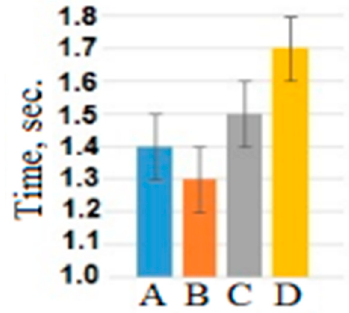
Figure 2. The reaction time averaged across all participants and assessments for different attribution objects: A—self-assessment, B—the loved person, C—the neutral person, D—the unpleasant person.